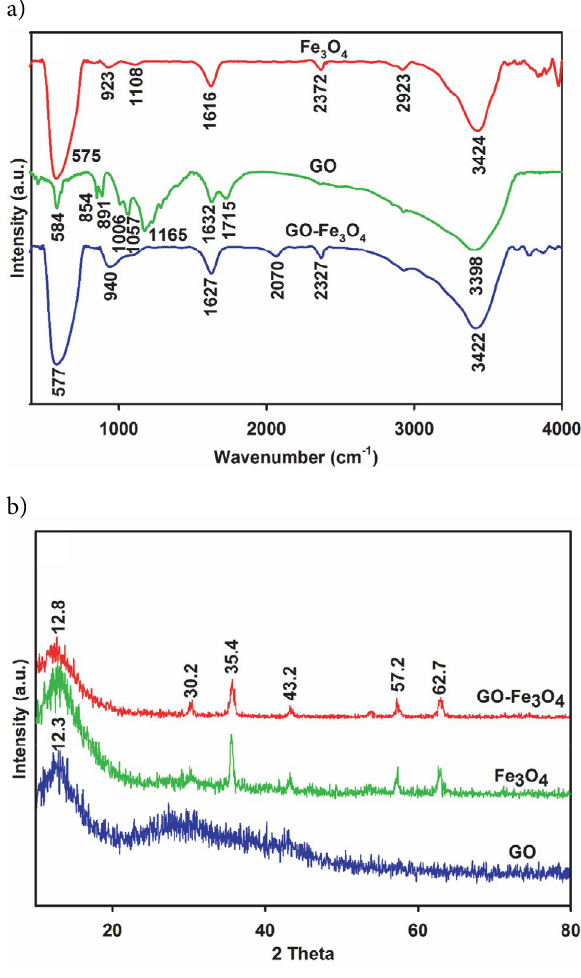
Figure 1. (a) FTIR and (b) XRD results of Fe 3 O 4 , GO and GO-